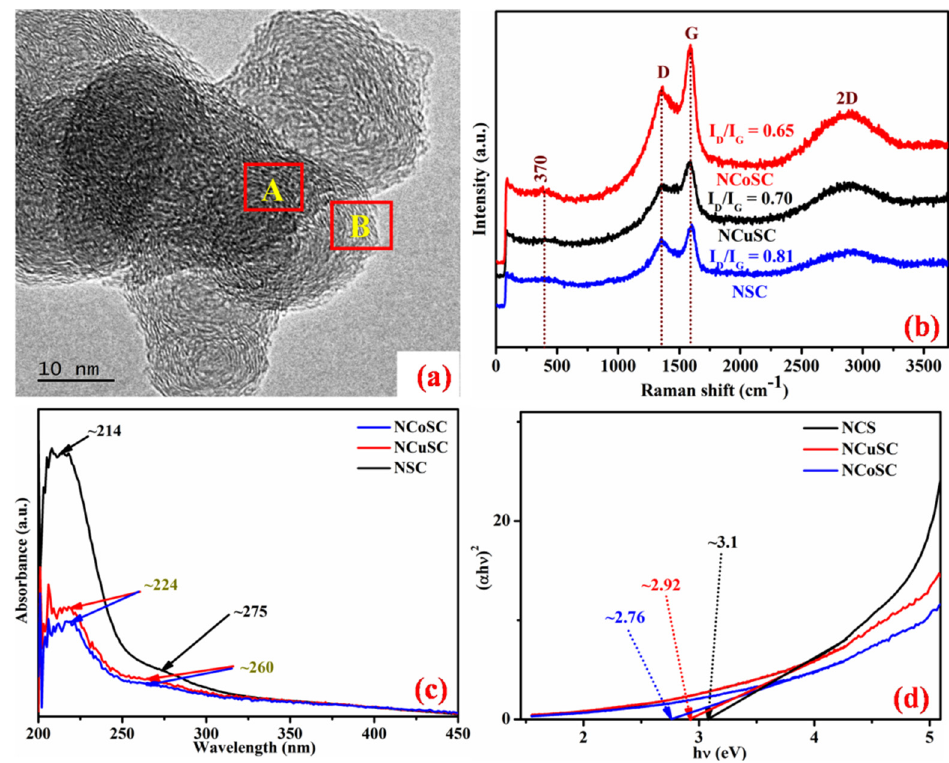
Figure 2. ( a ) HR — TEM image of NCoSC ( b ) Raman spectra ( c ) UV — vis spectra and ( d ) ( α h ν ) 2 vs h ν plot of NSC, NCuSC, and NCoSC electrodes. h ν plot of NSC, NCuSC, and NCoSC